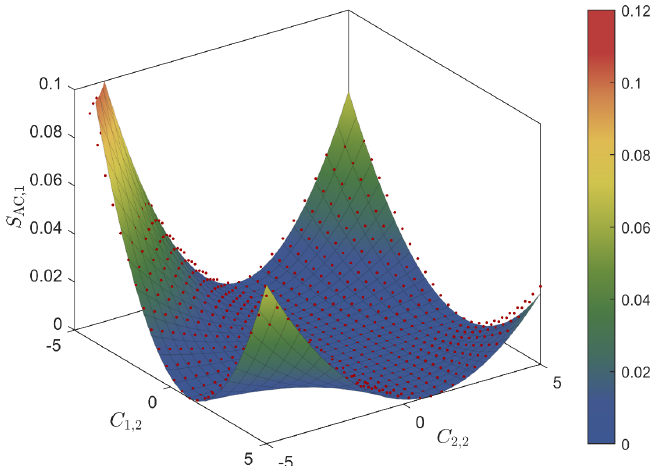
Figure 2 . S AC , 1 (red points) and fitted surface vs. C 1 , 2 , C 2 , 2 with m 1 = m 2 = m , G N m 2 = 10 − 5 , | b | m = 10 , p/m = 100 . In this Scenario II of the high-energy regime, the tripartite information is sensitive to the theory. The surface is fitted by 0 . 000115( C 1 , 2 − 1) 2 ( C 2 , 2 − 1) 2 , which suggests that (3.26) gives the right form of the leading term. The minimal occurs at (1 , 1)